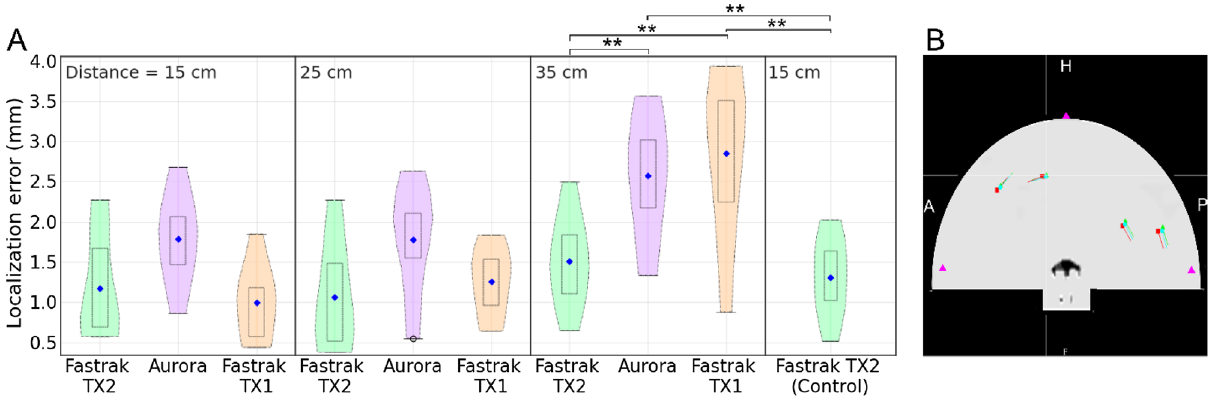
Figure 8. ( A ) Localization error for the eight dipoles, ( B ) the estimated position and orientation of four of the eight dipoles, when the digitization was done using the three different systems. The three magenta triangles represent the location of the HPI coils in the anterior (A), superficial (H: head), and posterior (P)